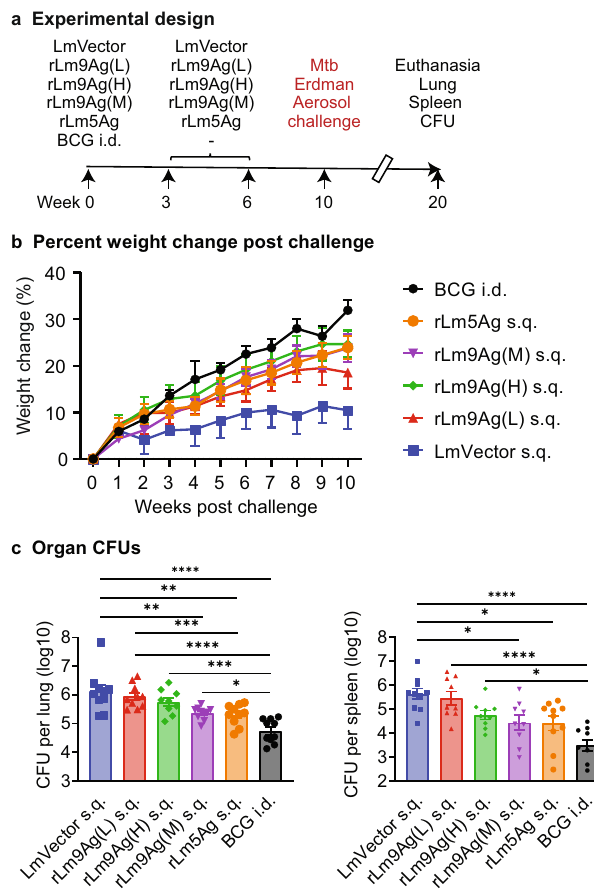
Fig. 10 Protective ef fi cacy of rLm9Ag and rLm5Ag vaccines against Mtb aerosol challenge in guinea pigs. a Experimental design. Guinea pigs ( n = 10/group) were immunized i.d. with 10 3 CFU BCG (Positive Control) at Week 0, or immunized s.q. three times with rLm9Ag at 10 5 (low dose, L), 10 6 (Medium dose, M), or 10 7 (High Dose, H) CFU, or with 10 6 rLm5Ag at Weeks 0, 3, and 6. The animals were then challenged at Week 10 with aerosolized Mtb Erdman strain. Afterwards, animals were monitored for signs of illness and weight change weekly for 10 weeks. At Week 10 post challenge, animals were euthanized and their spleen and right lungs were removed and assayed for bacillus burdens. b Percent weight change post challenge. Shown are means ± SEM. See Supplementary Fig. 8 for data points. See Supplementary Table 2 for statistical analyses comparing LmVector, rLm5Ag, rLm9Ag, and BCG groups by two-way ANOVA with Tukey ’ s multiple comparisons test (Prism 9.2.0). c Right lung (left) and spleen bacterial burden. Shown are means ± SEM. Each symbol represents one animal. * P < 0.05; ** P < 0.01; *** P < 0.001; and **** P < 0.0001 by one- way ANOVA with Tukey ’ s multiple comparisons